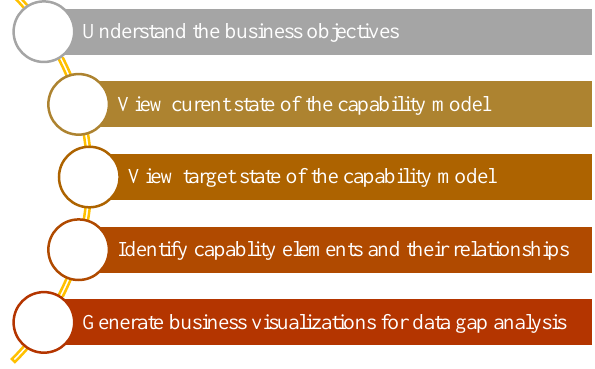
Figure 4. BA stages for modeling capabilities